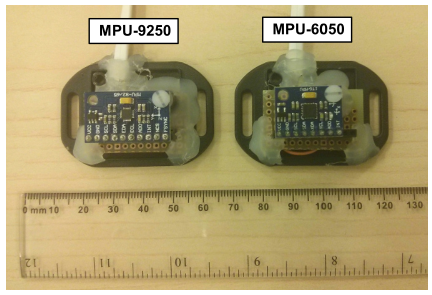
Figure 1. MPU-9250 and MPU-6050 sensor modules used in the experiment. Table 1. Specifications of MPU-6050 and